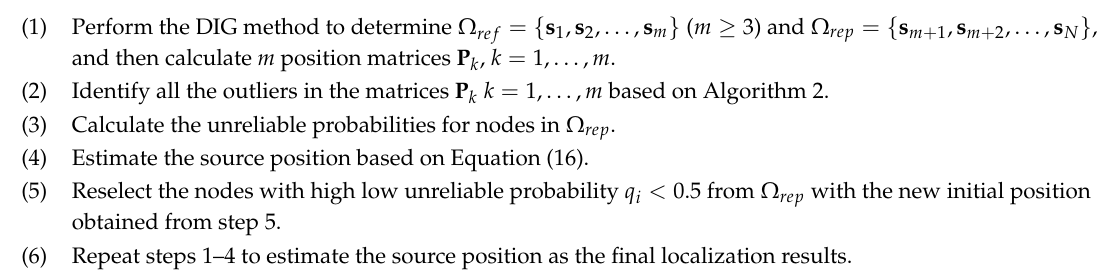
Algorithm 4. The procedure of the proposed method based on DIG and MD: